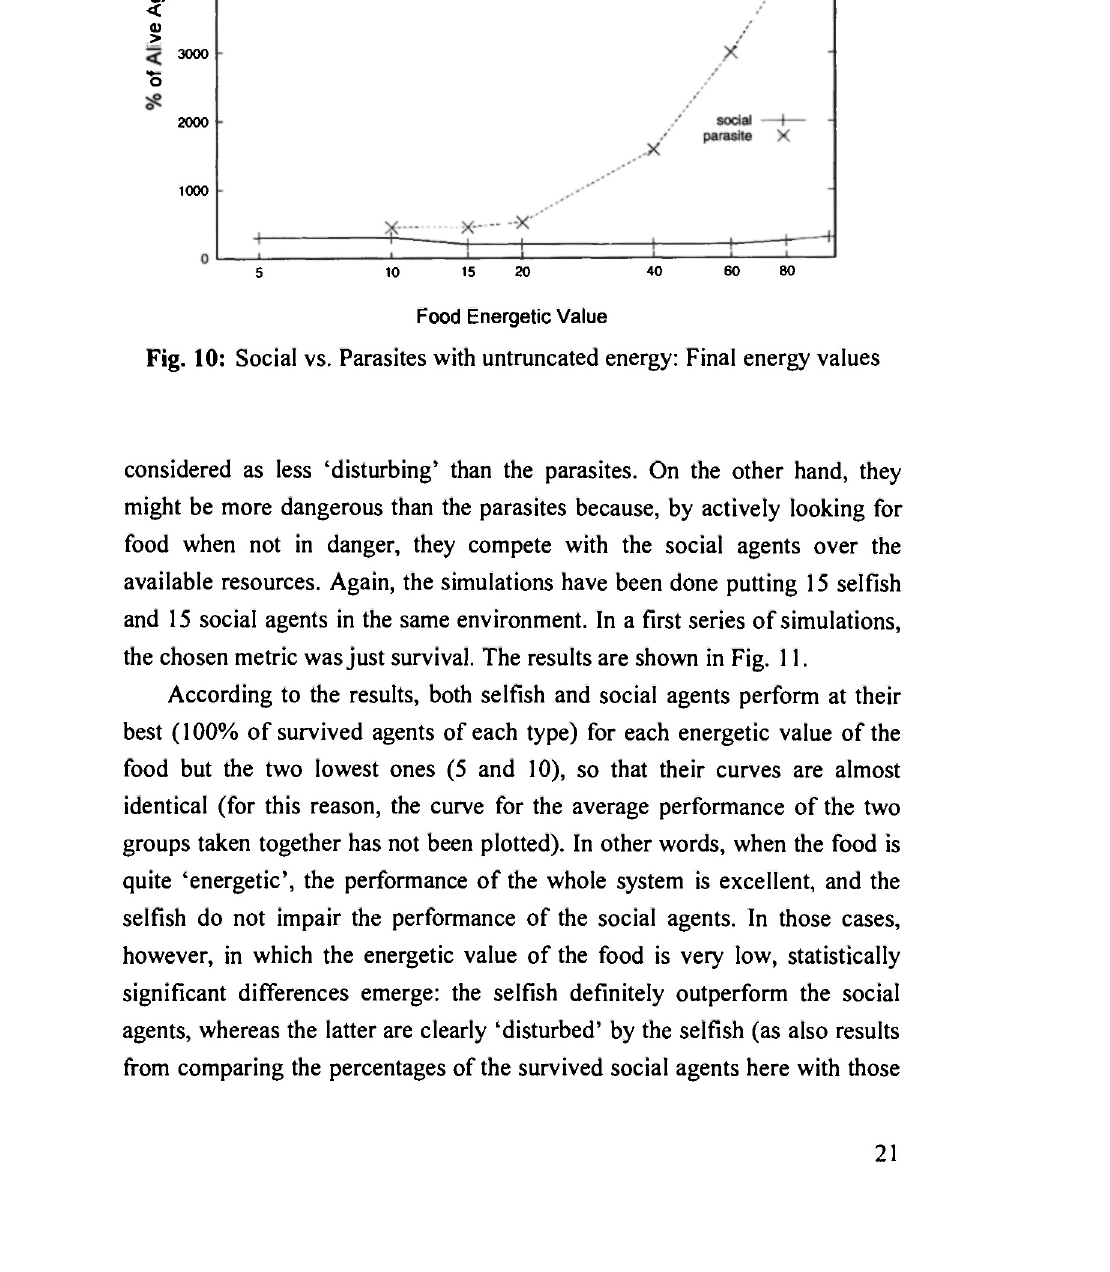
Fig. 10: Social vs. Parasites with untruncated energy: Final energy values